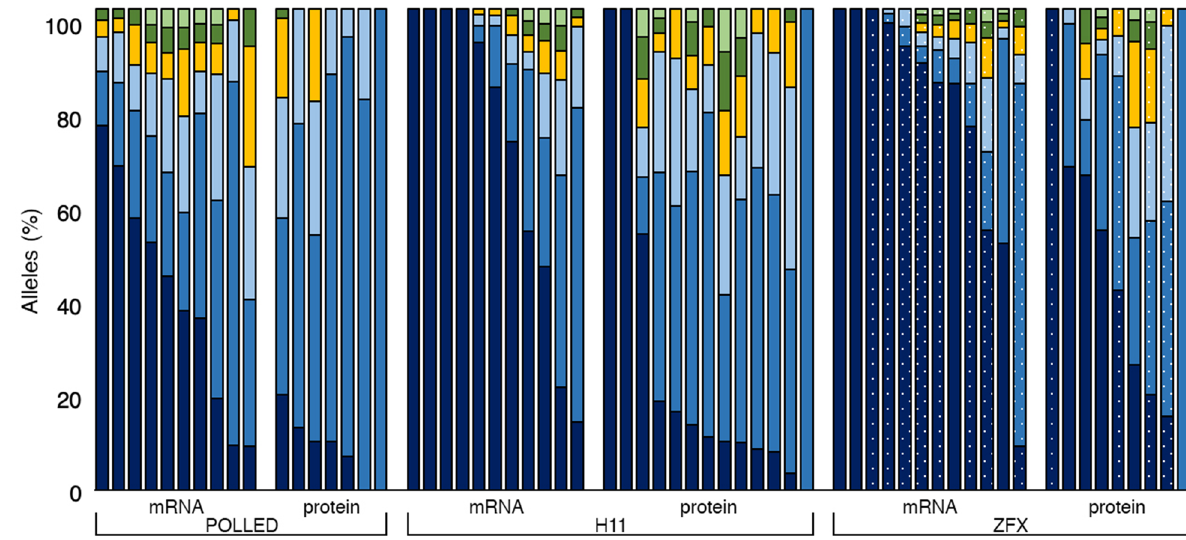
Figure 2. Bar graph depicting the percentage of alleles determined by PacBio sequencing in each of the 62 blastocysts microinjected 18 h post insemination with either Cas9 mRNA or protein and gRNAs targeting the POLLED, H11 and ZFX loci. Samples contained some combination of the wild type allele (dark blue) or an allele containing an insertion or deletion mediated by non-homologous end joining (blue, light blue, yellow, dark green and light green). For ZFX locus: dotted bars are female; solid bars are male.